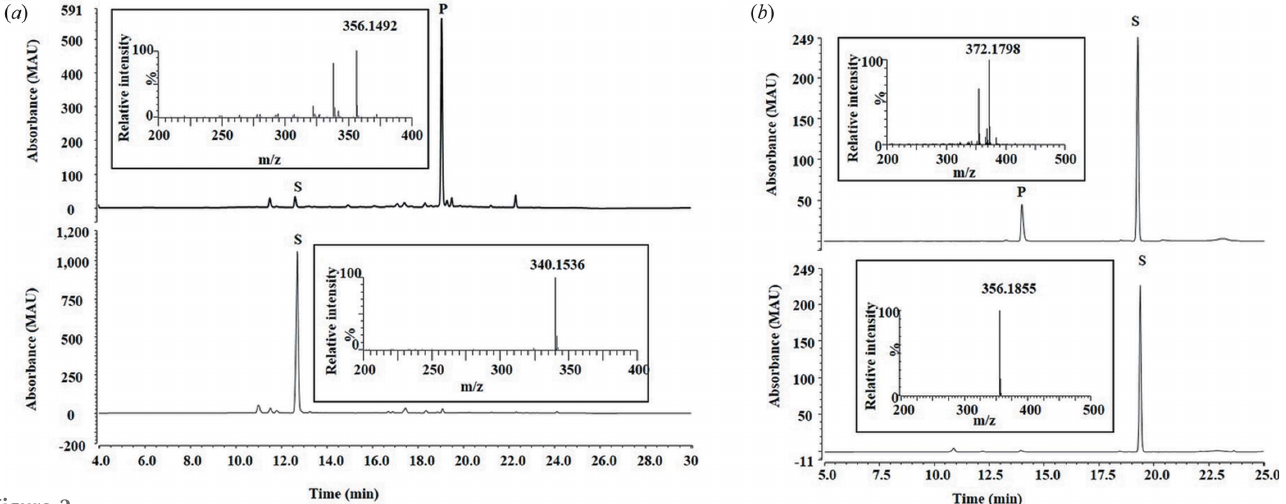
Figure 2 HPLC chromatogram and LC-MS spectra (inside the box) for ( a ) papaverine and ( b ) tetrahydropalmatine. The reaction (above) was performed with 400 m M substrate and 3 m M CYP105D18 in the presence of 40 m M H 2 O 2 for 1 h. A similar reaction condition was used for the control (below), with the use of 3 m M heat-deactivated CYP105D18 (positive control) and without the CYP105D18 (negative control). The positive and negative controls showed a similar HPLC chromatogram without any product